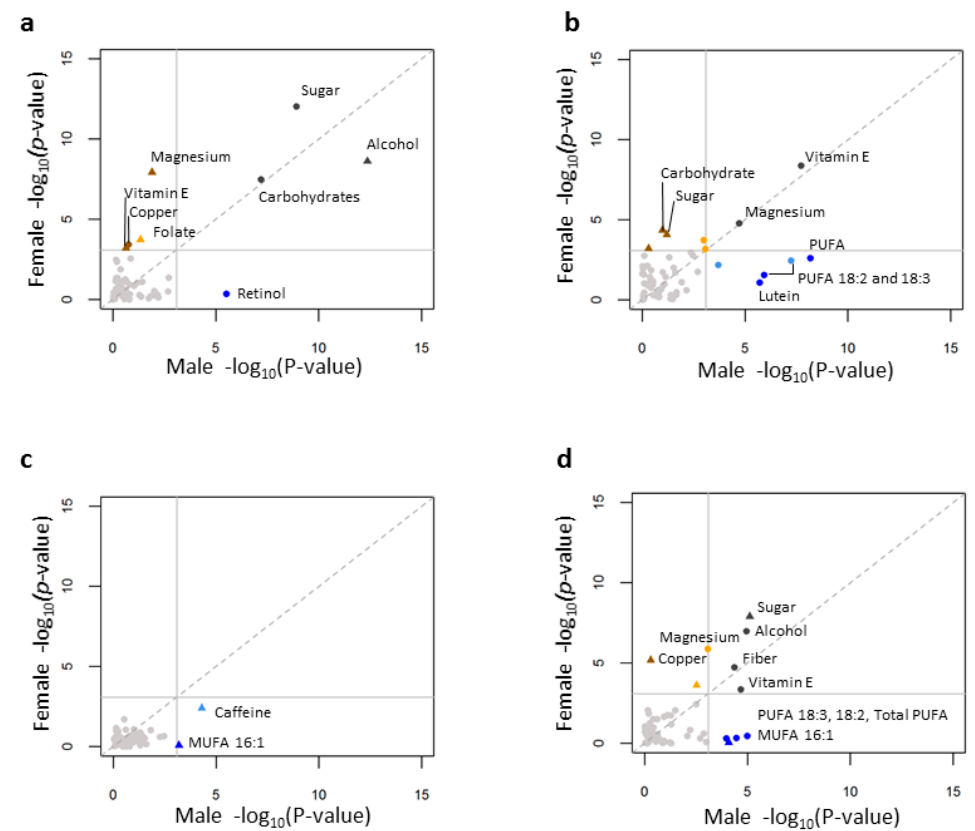
Figure 2. Scatter plot showing the correlation between multivariable-adjusted linear association of circulating lipid levels and individual nutrients in males and females. The x and y axes represents log 10 ( p -values) for female and male analyses of HDL cholesterol ( a ), TG ( b ), LDL cholesterol ( c ), and TC:HDL cholesterol ratio ( d ). The Bonferroni adjusted p -value cutoff ( p = 0.000833) is indicated as the horizontal and vertical solid gray line. Non-significant points are shown in grey. Grey points correspond to significant associations in both genders. Significant female or male only points are shown in brown and orange or blue, respectively. Brown and dark blue points represent sites where the beta-coefficient of the significant association is > 2 × that of the non-significant association. Orange and light blue represent a 1.5 × difference.